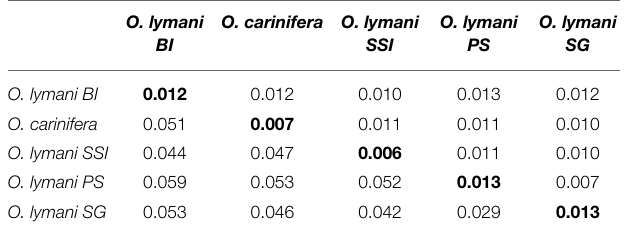
TABLE 2 | Average pairwise distances between clades (below diagonal), associated standard error estimates (above diagonal) and within clades distances (along the